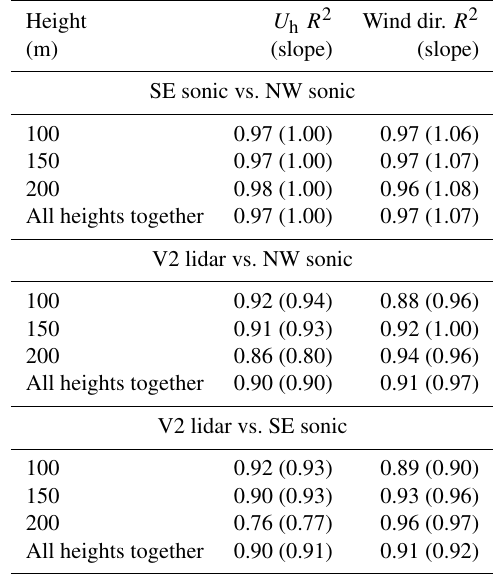
anemometer and NW sonic anemometer data for 24h data reported in Fig.